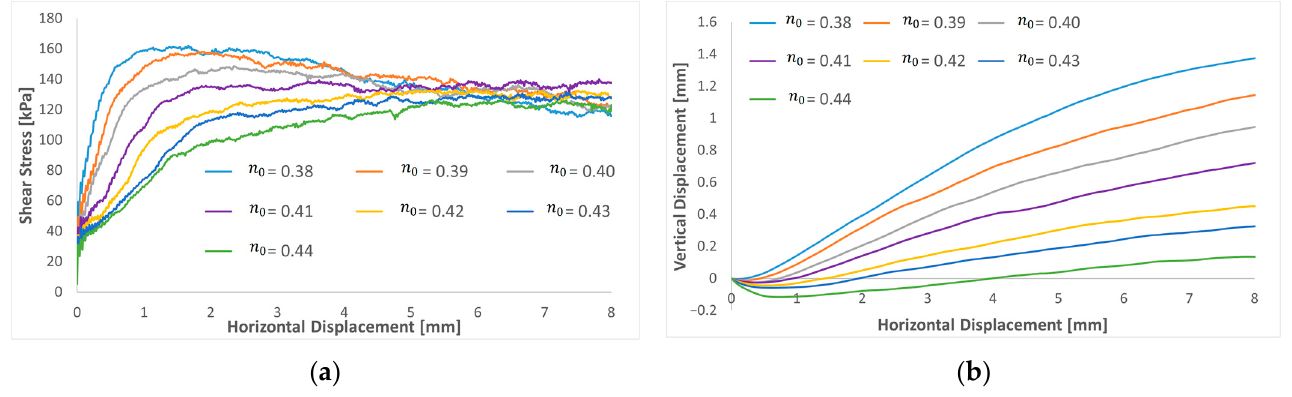
Figure 10. Shear stress and dilatation curves of varying porosity: ( a ) shear stress versus shear strain; ( b ) volumetric strain versus shear strain.